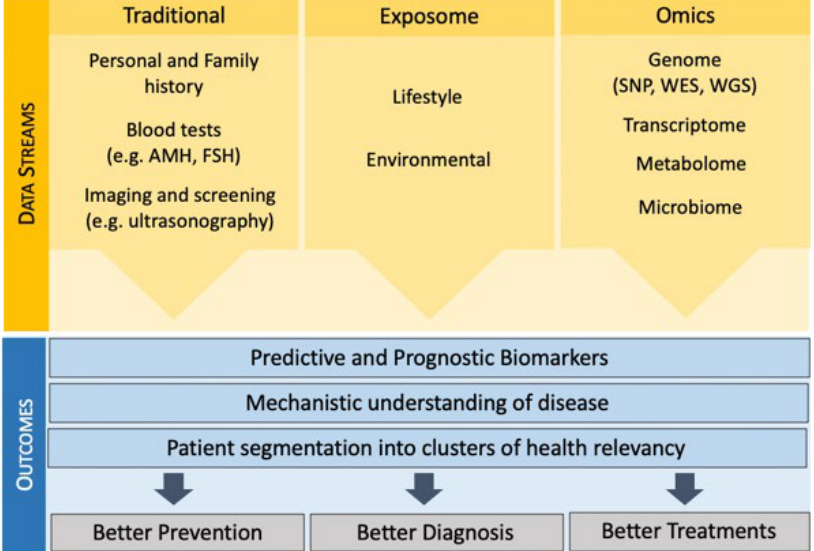
Figure 2. Data streams used to enable precision medicine in the Infertility sector. The newer health data streams such as genomics, the microbiome and the exposome are a complement to traditional approaches used in infertility investigations and management, to ultimately deliver better prevention, diagnosis and treatments.